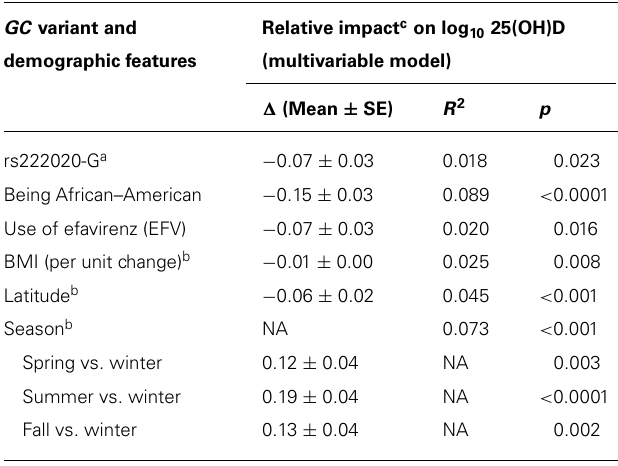
Table 3 | Univariable analyses of seven GC SNPs using baseline (week 0) serum 25(OH)D concentration as three ordinal categories (deficiency, insufficiency, and sufficiency).